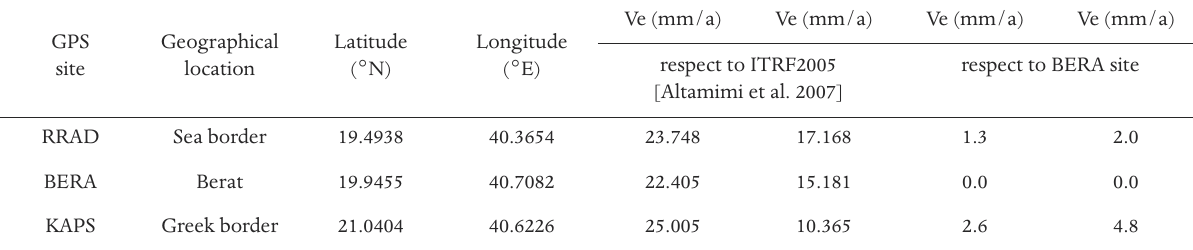
Table 3. Velocities of GPS sites in a ITRF2005 [Altamimi et al. 2007] (from Jouanne et al. [2012]). Ve and Vn are respectively the component of velocity towards E and N. See text for discussion of the velocity with respect to BERA at the hanging wall of the